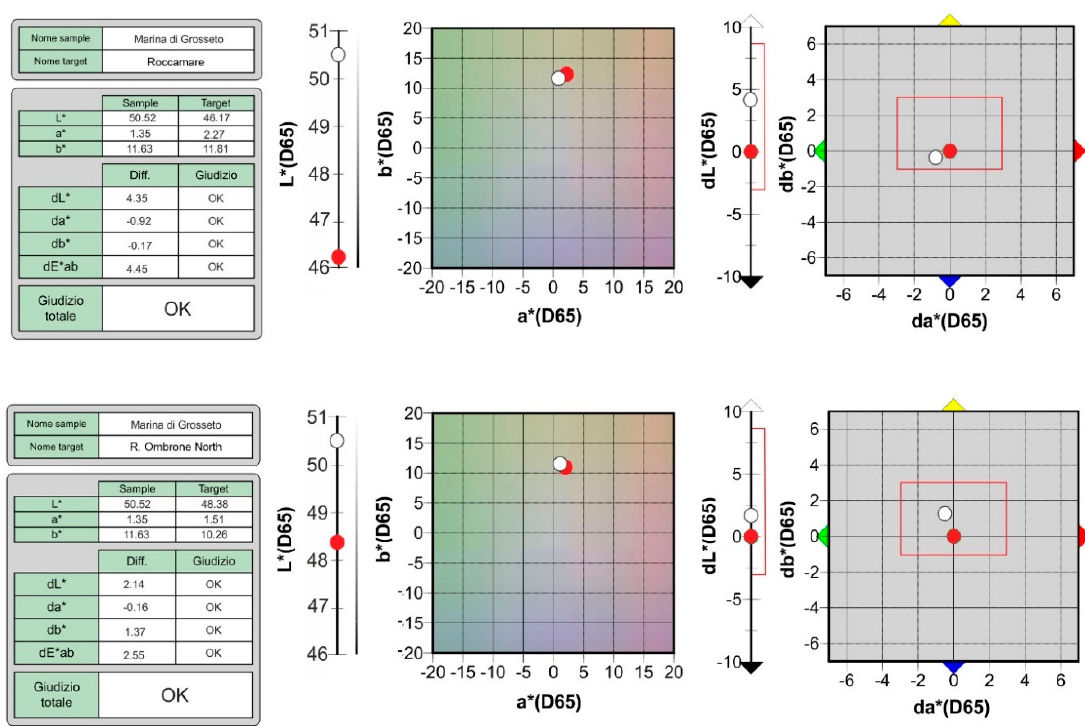
Figure 10. Colour compatibility of Marina di Grosseto sand (Sector 44) with that of Roccamare (Sectors 39, 40) and of Ombrone River North (Sector 45). Acceptability range is delimited in red on dL* axis, with a red rectangle on a*, b* plain. The left graph shows L* and a*b* absolute values of native (with dot) and borrowed (red dot) sediments; the right graphs show distance of borrowed sediments from native ones.